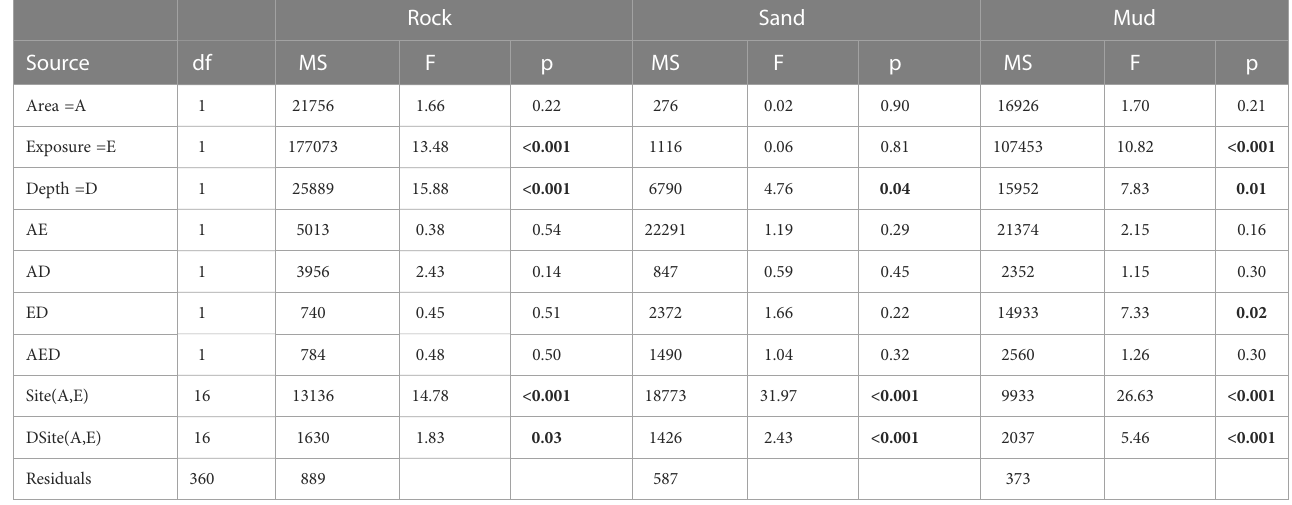
TABLE 1 Analysis of variance results of the cover of rock (including boulders and stones), sand and mud measured by visual inspection. Rock Sand